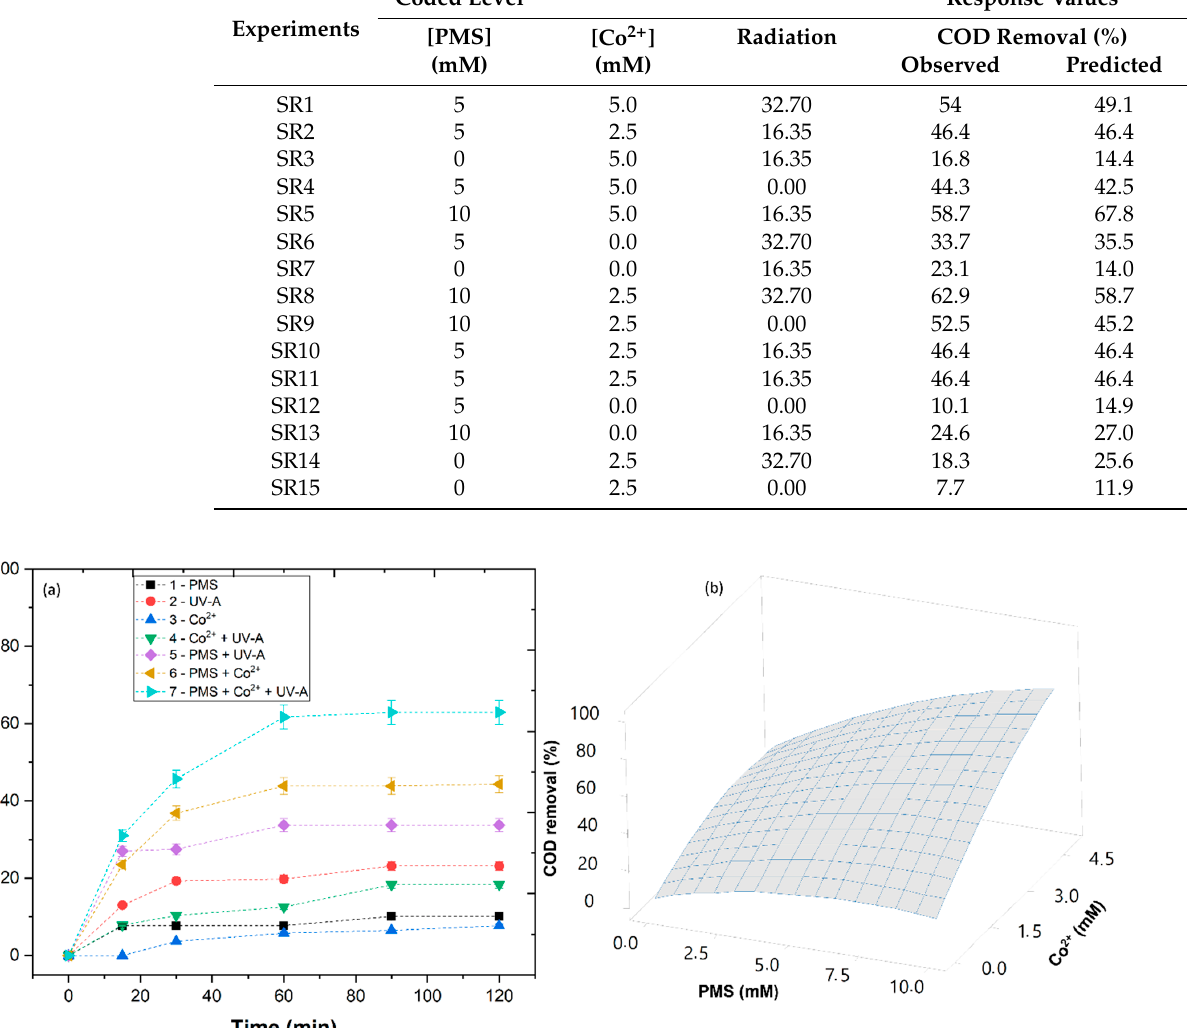
SR13 Table 3. Box–Behnken design: effect of operational variables on COD removal yield ([PMS] = 0–10 mM; [Co 2+ ] = 0–5 mM; radiation = 0–32.70 W m − 2 ). Operational conditions: COD = 616 mg O 2 /L, temperature = 323 K, pH = 6.0, reaction time = 120 min. Coded Level Experiments